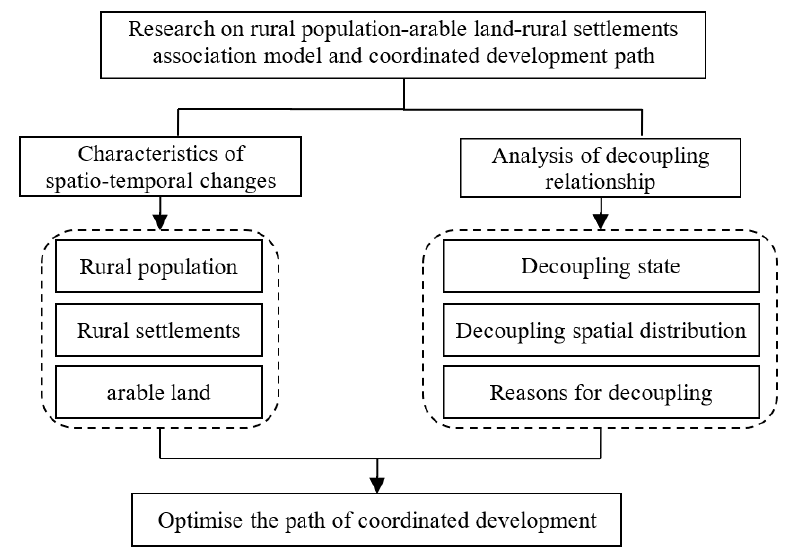
Figure 1. Theoretical framework diagram.